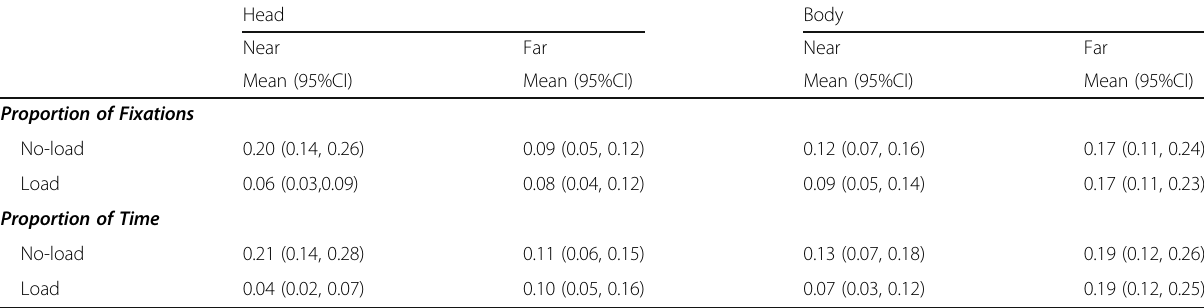
Table 5 Proportion of fixations toward the head and body for Condition (no-load, load) and Proximity (near, far) in Experiment 2 Head Body Near Far Near Far Mean (95%CI) Mean